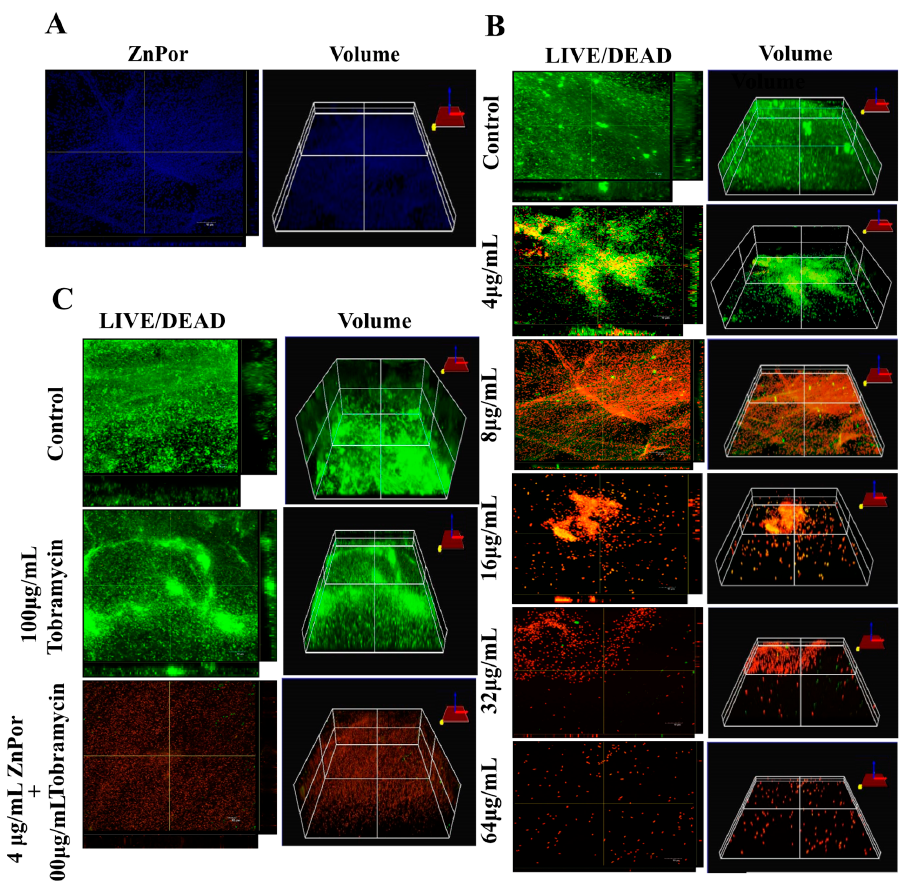
Figure 2. The effect of ZnPor on PsA biofilms: These experiments used confocal microscopy to image PsA biofilms formed on polyethylene coupons in Center for Disease Control (CDC)